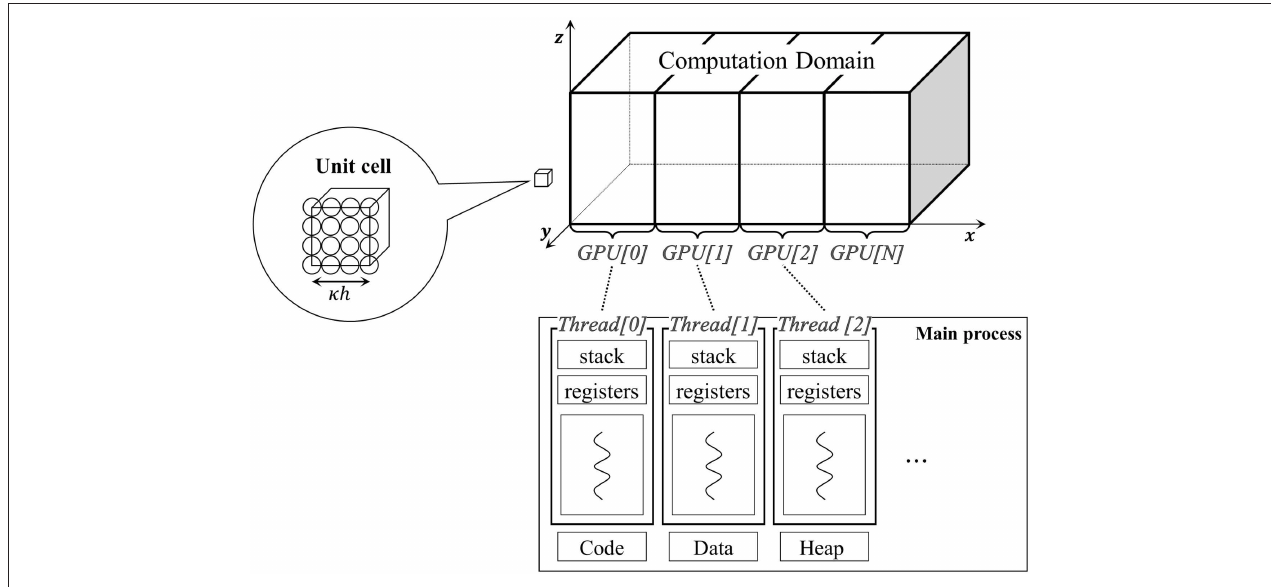
FIGURE 3 | Schematic process of the multi-GPU allocation step.